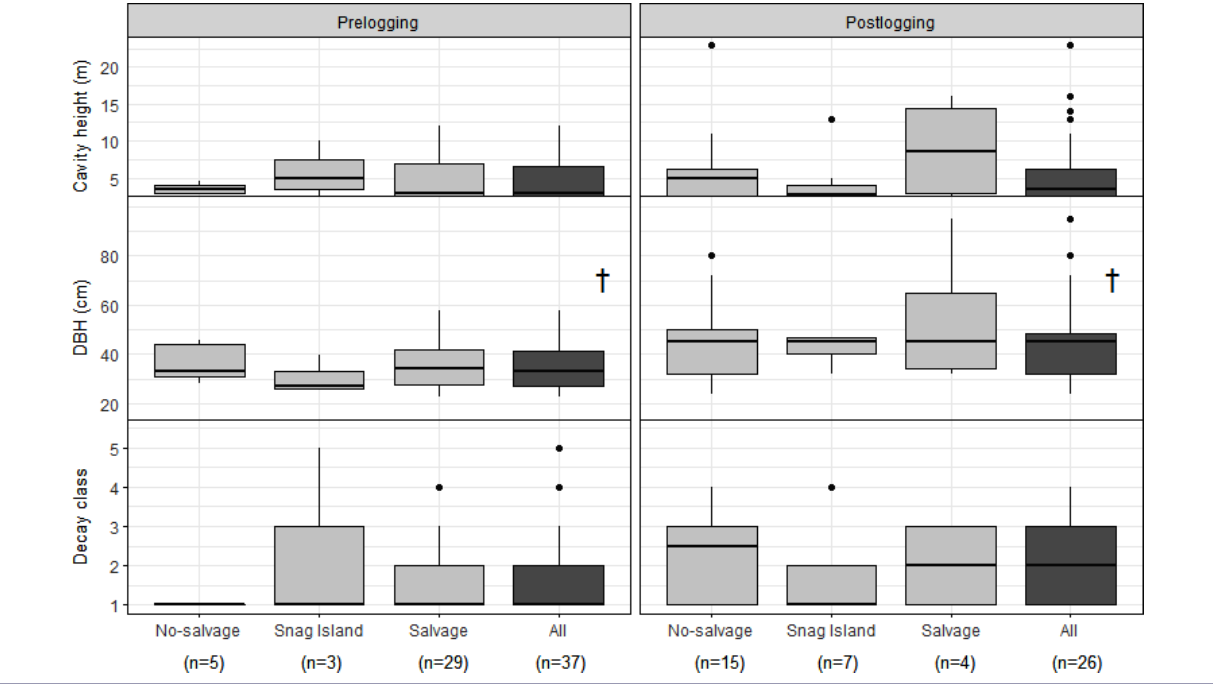
Fig. 3 . Black-backed Woodpecker ( Picoides arcticus ) nest tree characteristics by treatment type before and after logging. † Diameter at breast height (DBH) of Black-backed Woodpecker nest trees averaged over all treatments was significantly higher in the post- than in the prelogging period (F1, 57 = 9.45, p <